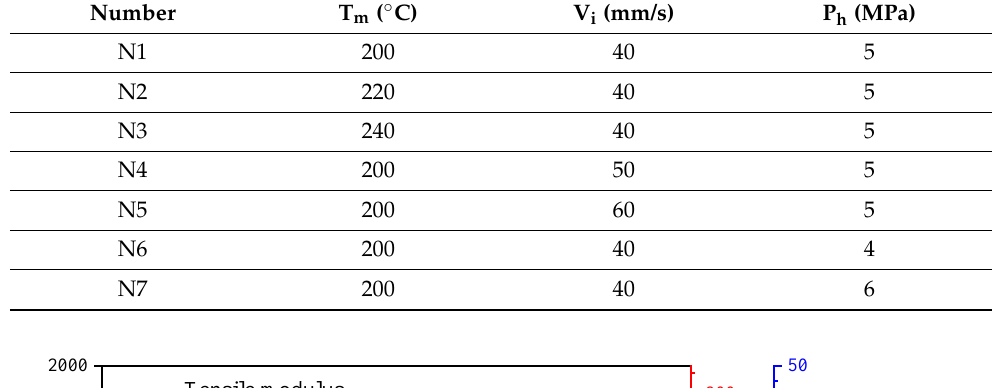
Figure 7. Stress–strain curve of the kaolin/PP composites. Table 1. Microinjection process parameters.